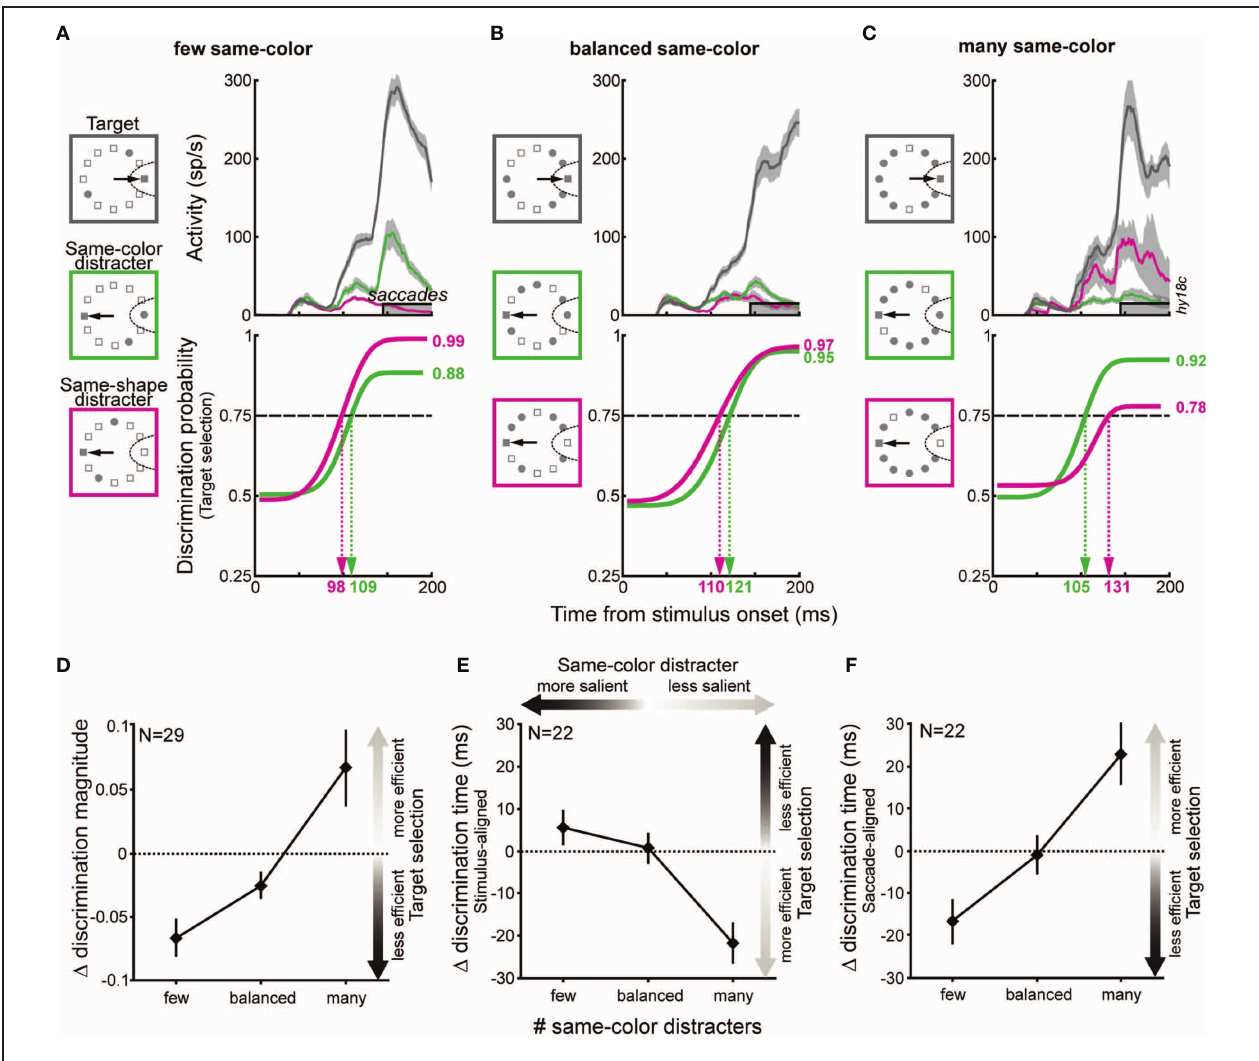
feature sensitivity on discrimination time, with data aligned on either stimulus-onset (E) or saccade-onset (F) . Only neurons with significant discrimination reaching the criterion of 0.75 in all conditions were included in (E) and (F) .